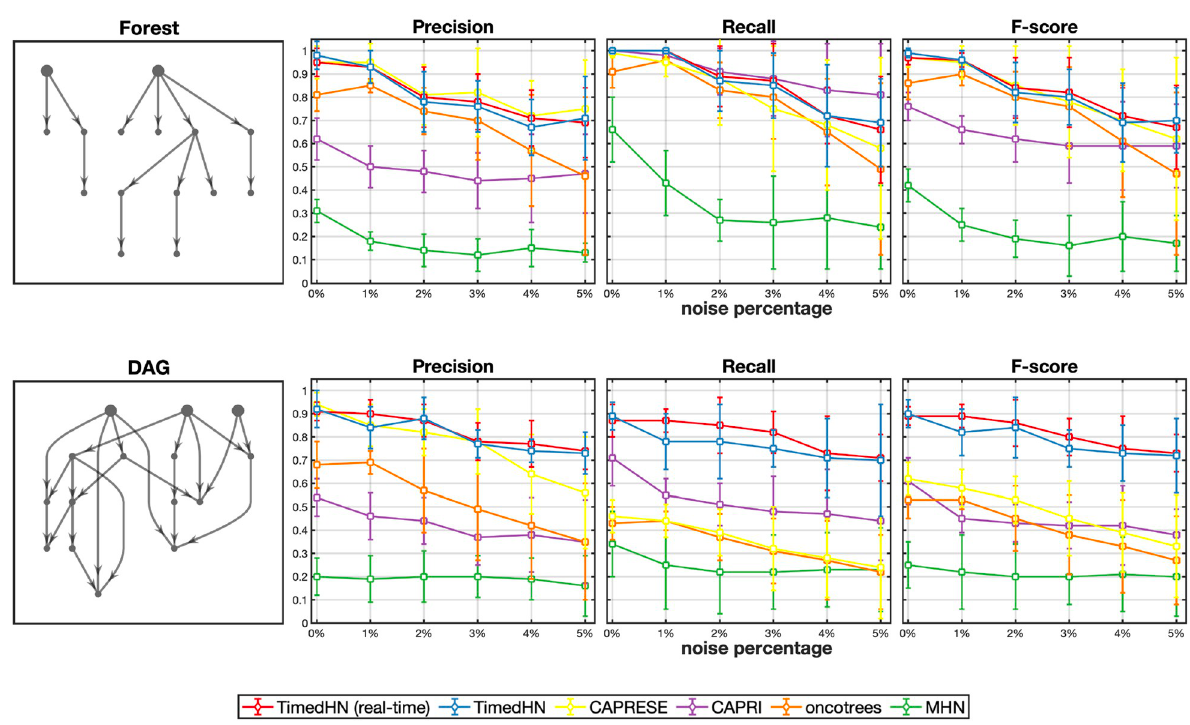
Fig 3. The precision, recall, and F-score of six methods was compared on synthetic datasets with 15 events. and uniform noise at six noise level (0.1%, 0.25%, 0.5%, 1%, 2.5%, 5%). The datasets were generated by sampling from CTMCs parameterized by forests and DAGs. Error bars represent one standard